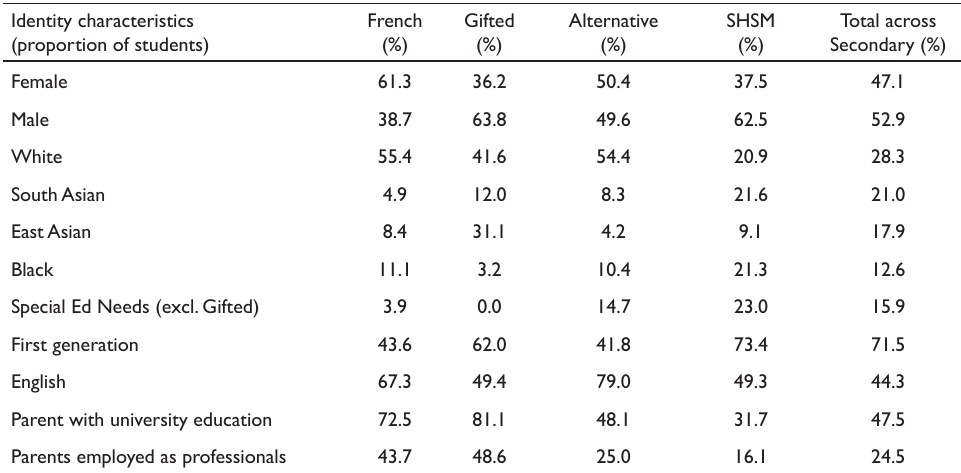
Table 2: IdentitycharacteristicsacrossprogrammesofchoiceintheTDSB,2011/12 5 Identitycharacteristics